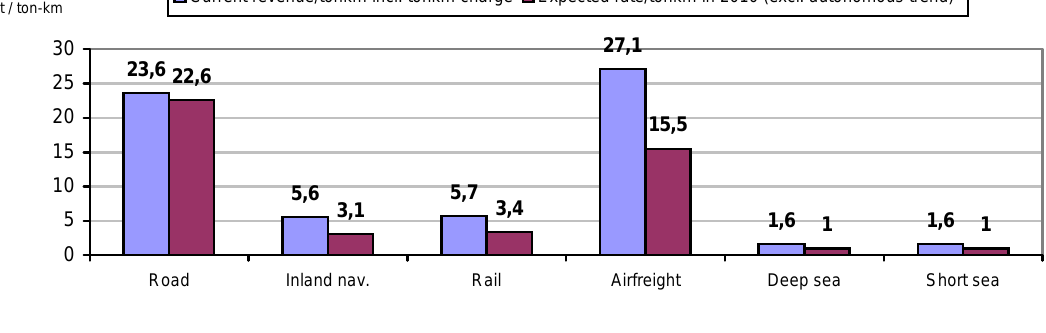
Figure 4. Comparison between freight rates in 2001, including ton-kilometer charge, and expected freight rates in